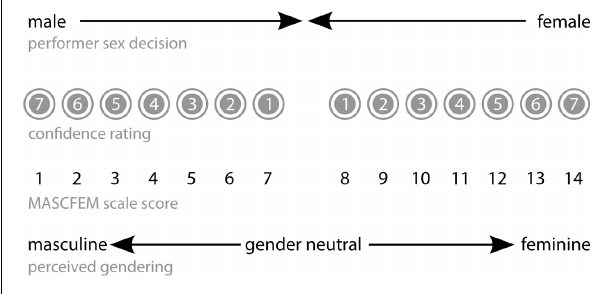
FIGURE 2 | Structure of the MASCFEM scale: perceived masculinity/ femininity of extracts and performances.